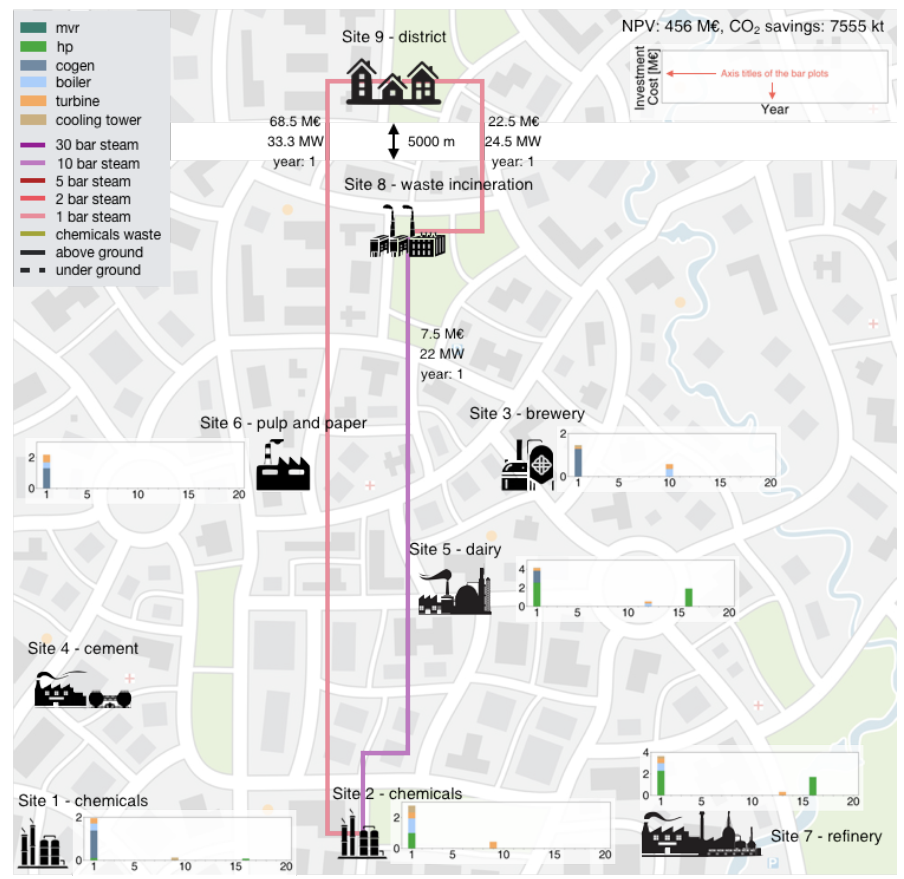
Figure 7. Optimal investment planning considering seasonality in district energy